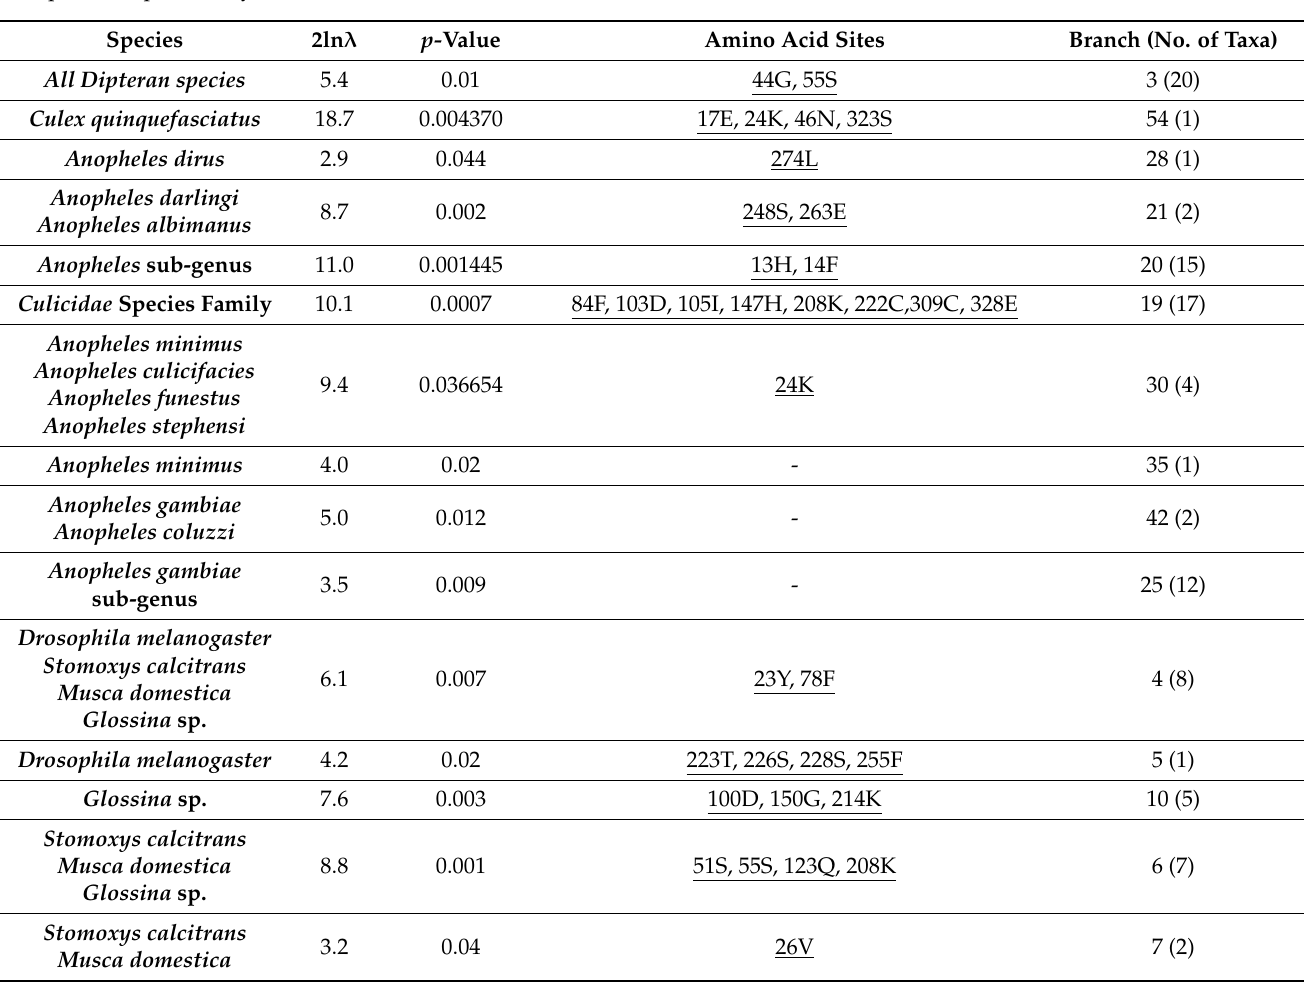
Table 1. CodeML analyses result of positive selection among DNMT2 orthologs. The column “Amino Acid Sites” shows codon positions with BEB posterior probability > 0.80 for having ω > 1. Underlined codon sites represent those with BEB posterior probability >